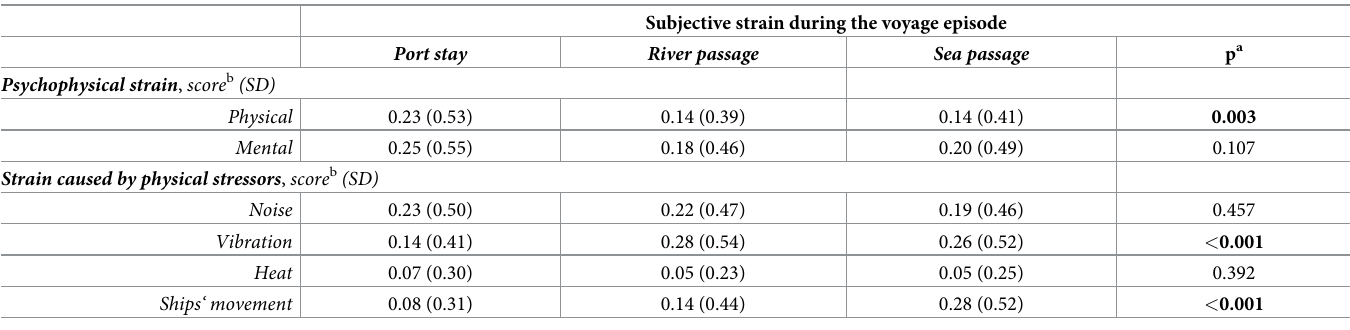
Table 2. Seafarers’ exposure according to voyage